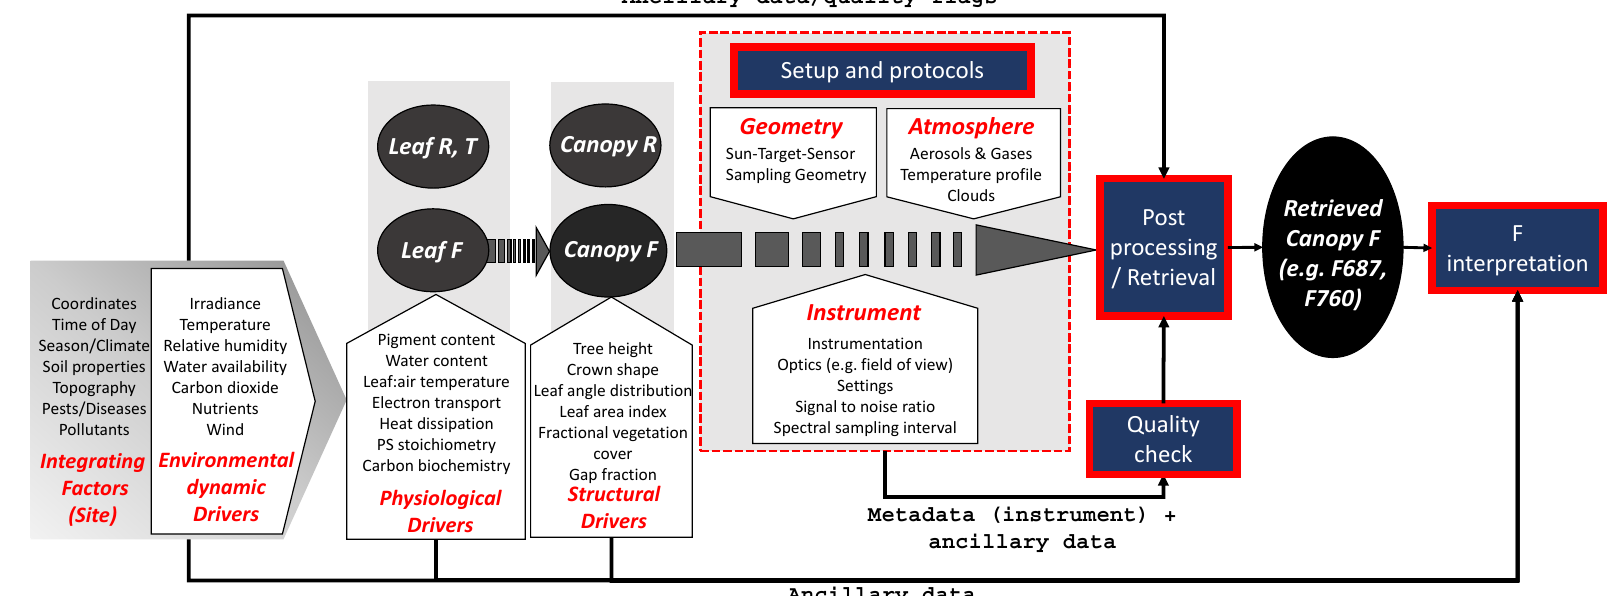
Figure 1. Environmental, physiological, physical, instrumental, and setup considerations at the leaf and canopy level for the acquisition, quality check, post-processing, retrieval, and interpretation of the sun-induced fluorescence (F) signal (PS: